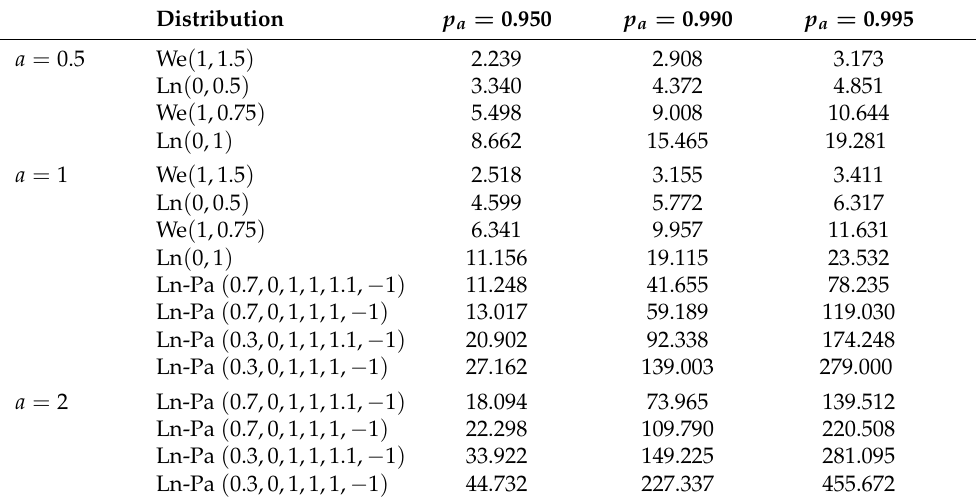
Table A2. Theoretical values of CQ p